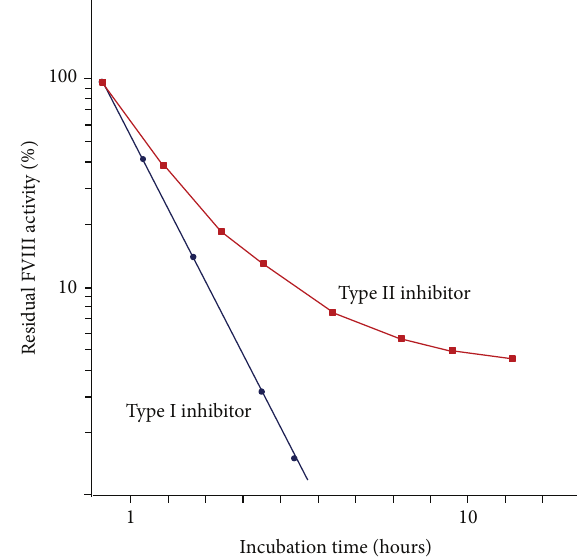
Figure 2: Kinetics of type I and type II